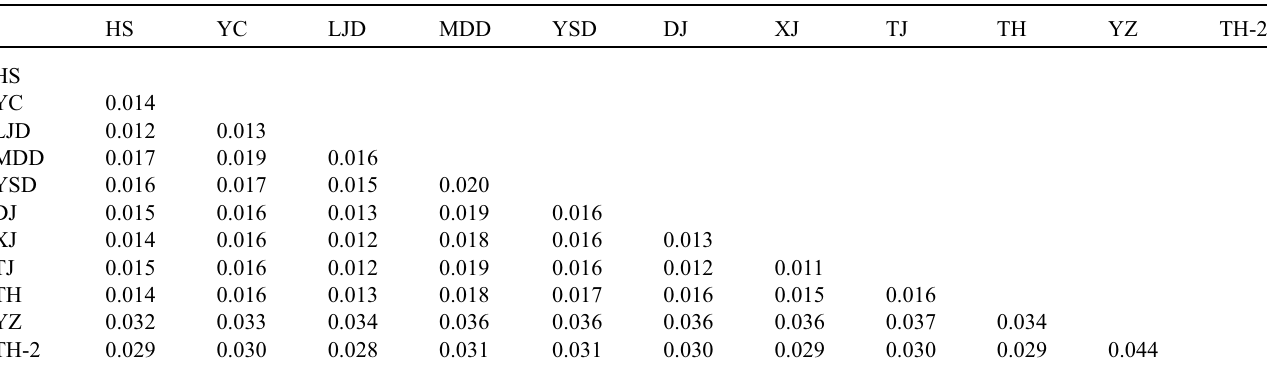
Table 5. Genetic distance of 11 M. nipponense